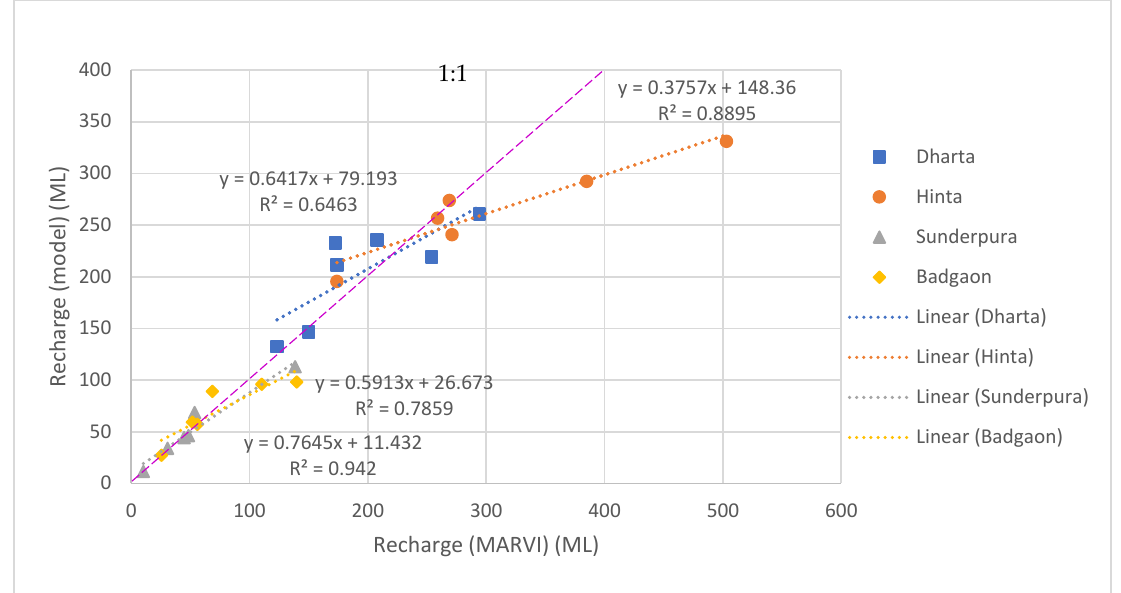
Figure 3. The annual recharge from the WaterCress model estimates compared with recharge calculated from MARVI check-dam water balance measurements (2014 – 2020).